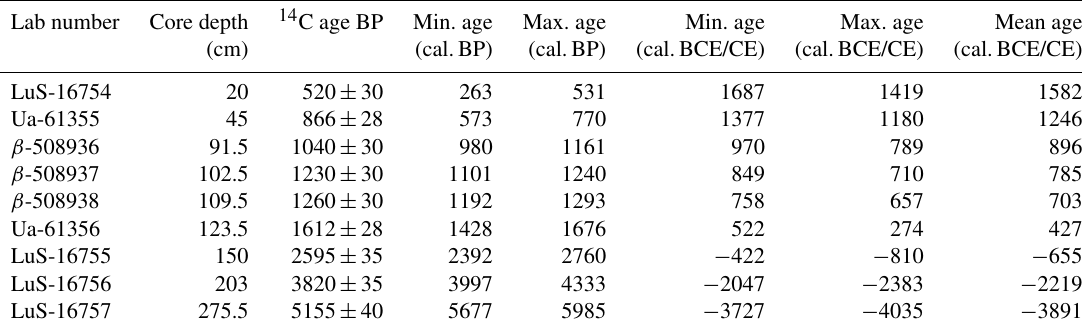
Table A1. Radiocarbon ages for Haraldstadmyr peat